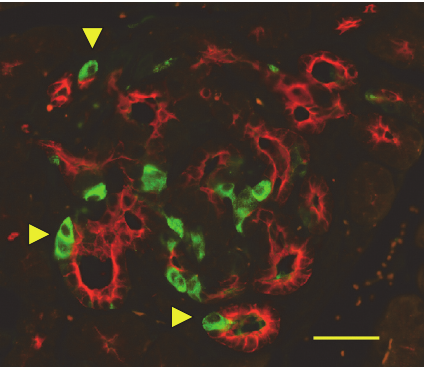
Figure 5: Insulin-expressing cells in the Tg mice ductal structures. Pancreas sections from Tg mice at 40 weeks of age costained with antibodies to insulin (green) and cytokeratin 17/19 (red). Yellow triangles denote insulin-positive cells in the structure. Bar, 40 𝜇 m.